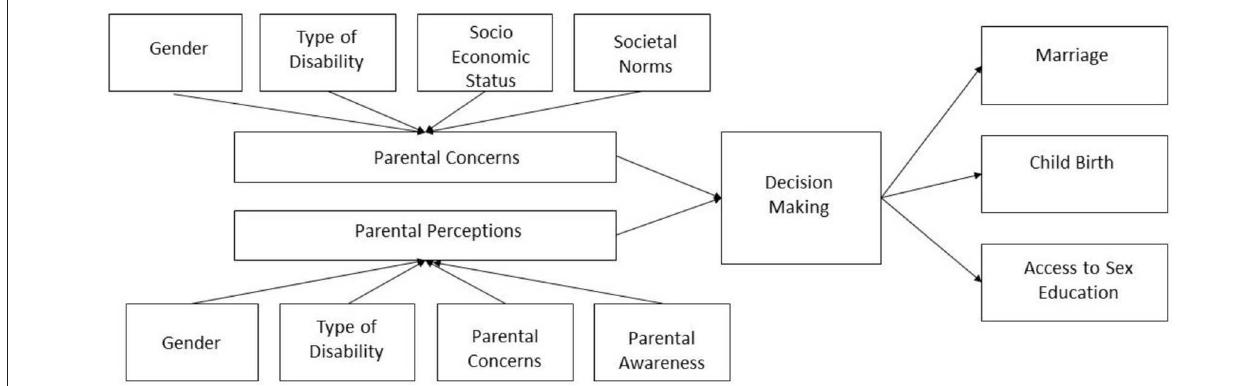
FIGURE 3 | Factors affecting parental perceptions and concerns and its influence on decision